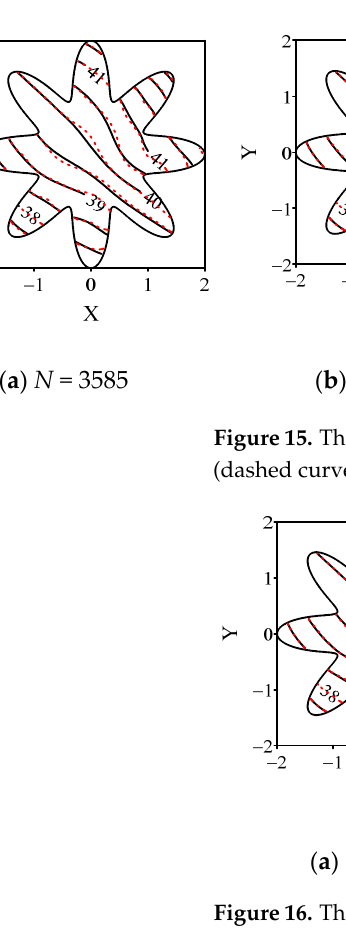
u in Step 1 (solid line) on 2